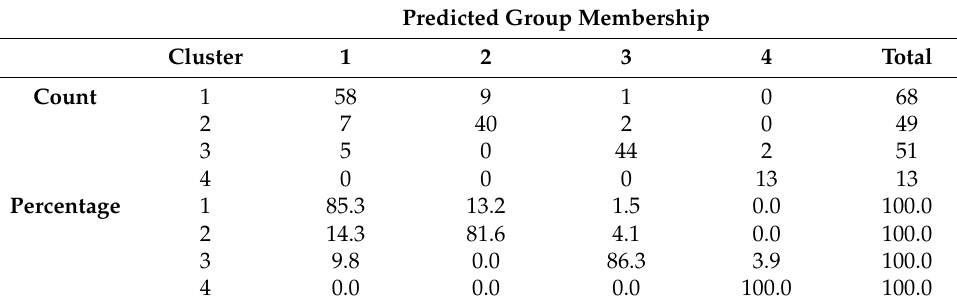
Table 3. The discriminant function classification results.